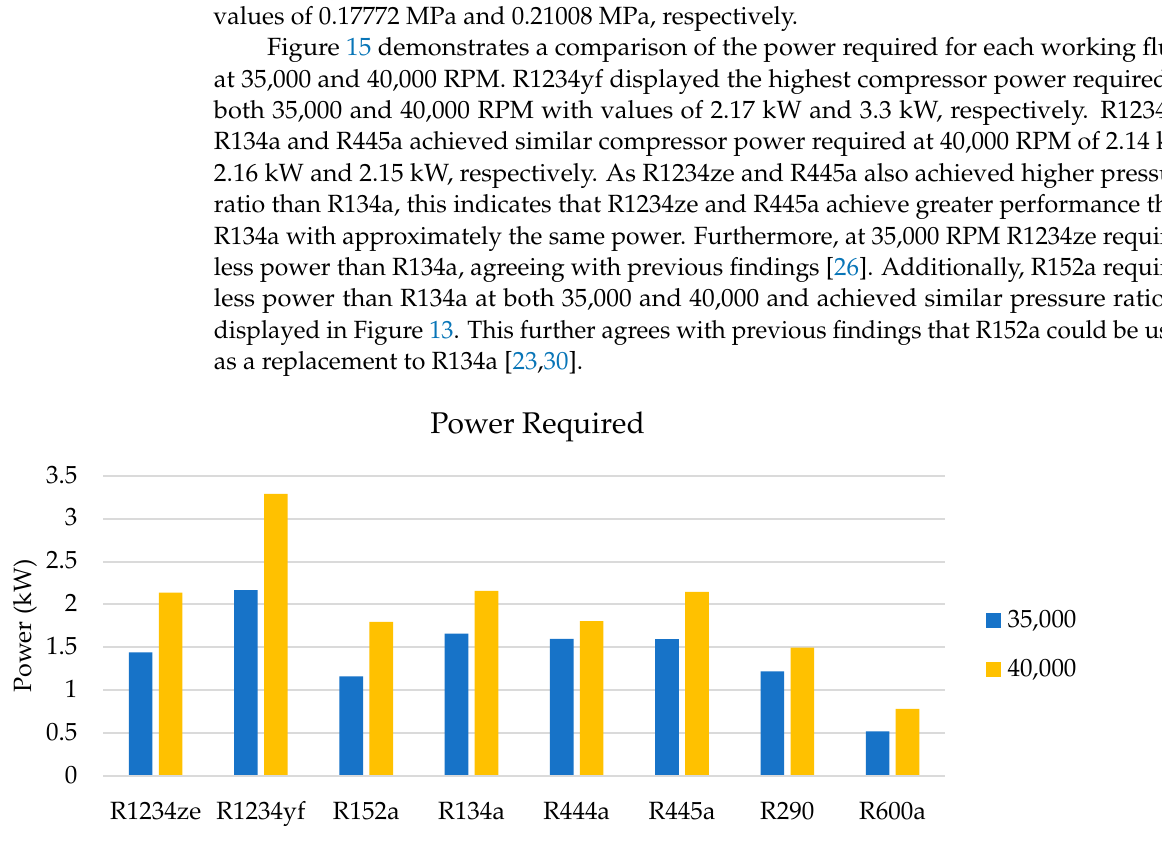
12 Figure 14. Comparison of Outlet Pressure Achieved for each Working Fluid at an RPM of 35,000 and 40,000. R152a, R444a and R445a demonstrated similar outlet pressures at both 35,000 and 40,000 RPM with values in the range 0.38683–0.39748 MPa and 0.46878–0.47133 MPa, for